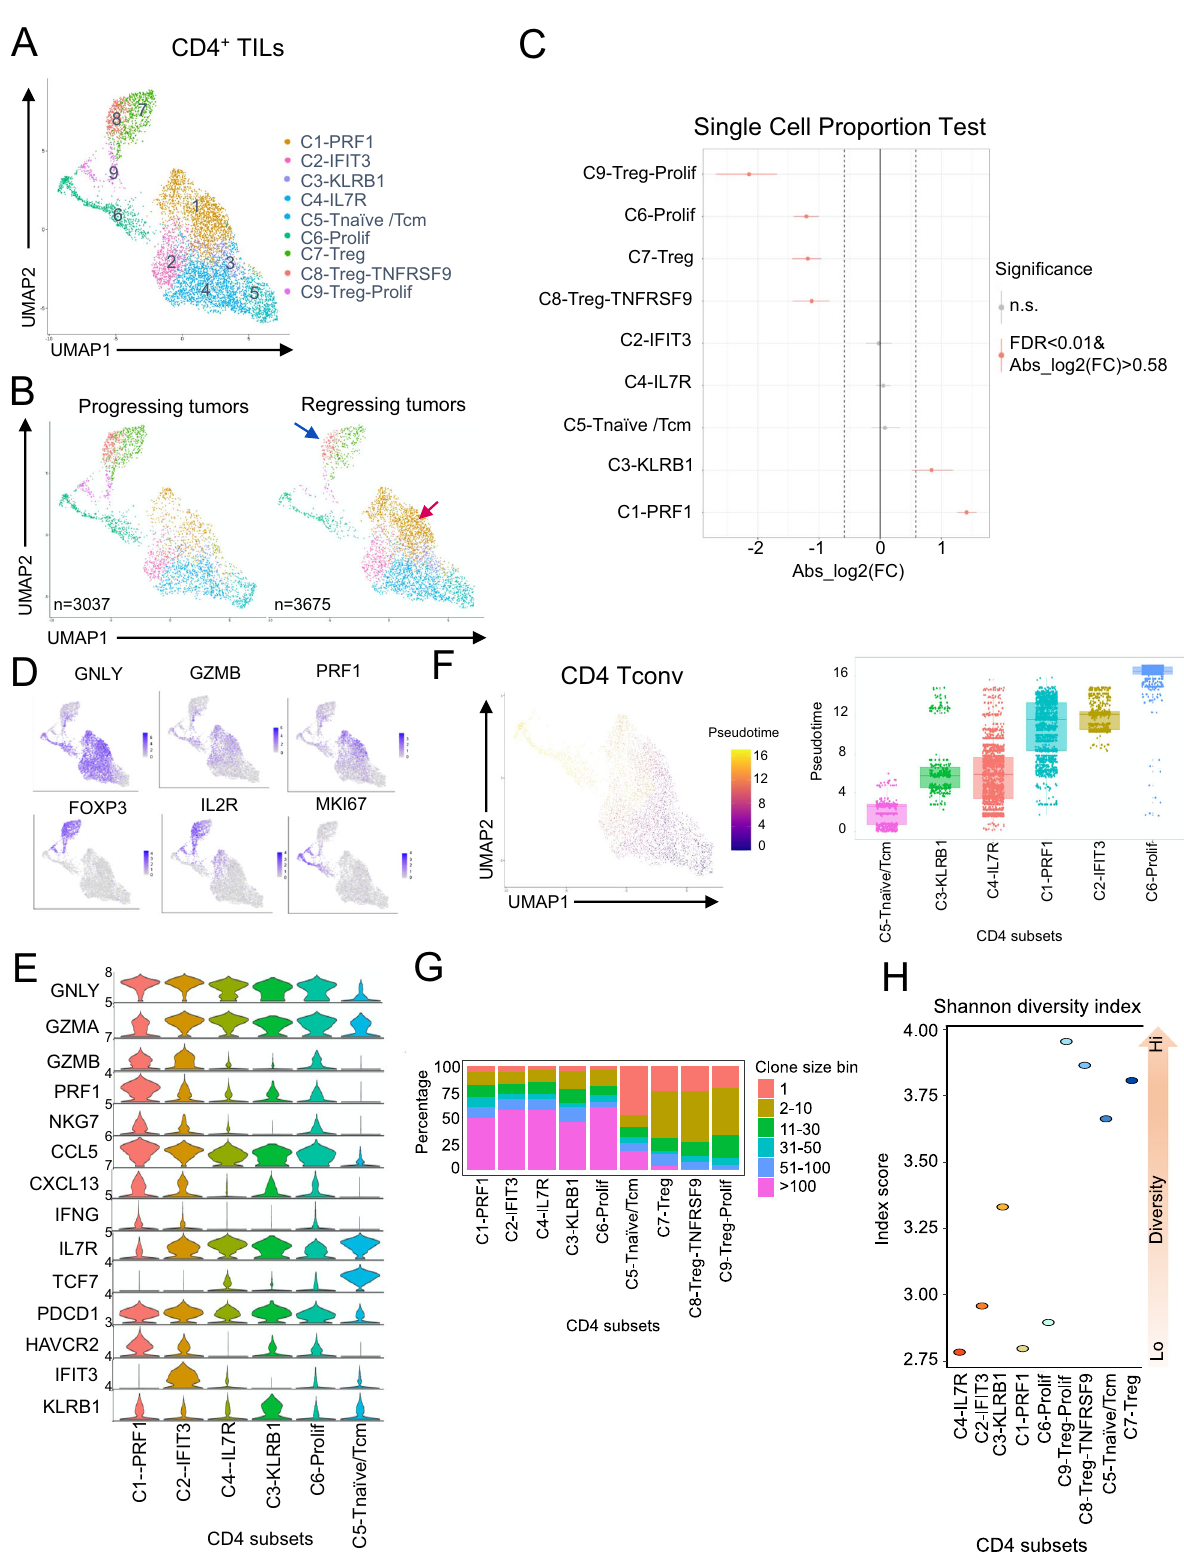
GZMB , GNLY , NKG7 , and PRF1 ) (Supplementary Data 2). Cells in cluster C4-IL7R upregulated IL7R, a marker of CD4 CTL precursors 50 . C2-IFIT3 cells upregulated multiple interferon- induced genes, including IFIT3 as the most distinctive one (Fig. 5E). Notably, C1-PRF1 demonstrated the strongest effector phenotype, re fl ected by high expression of cytotoxic ( PRF1